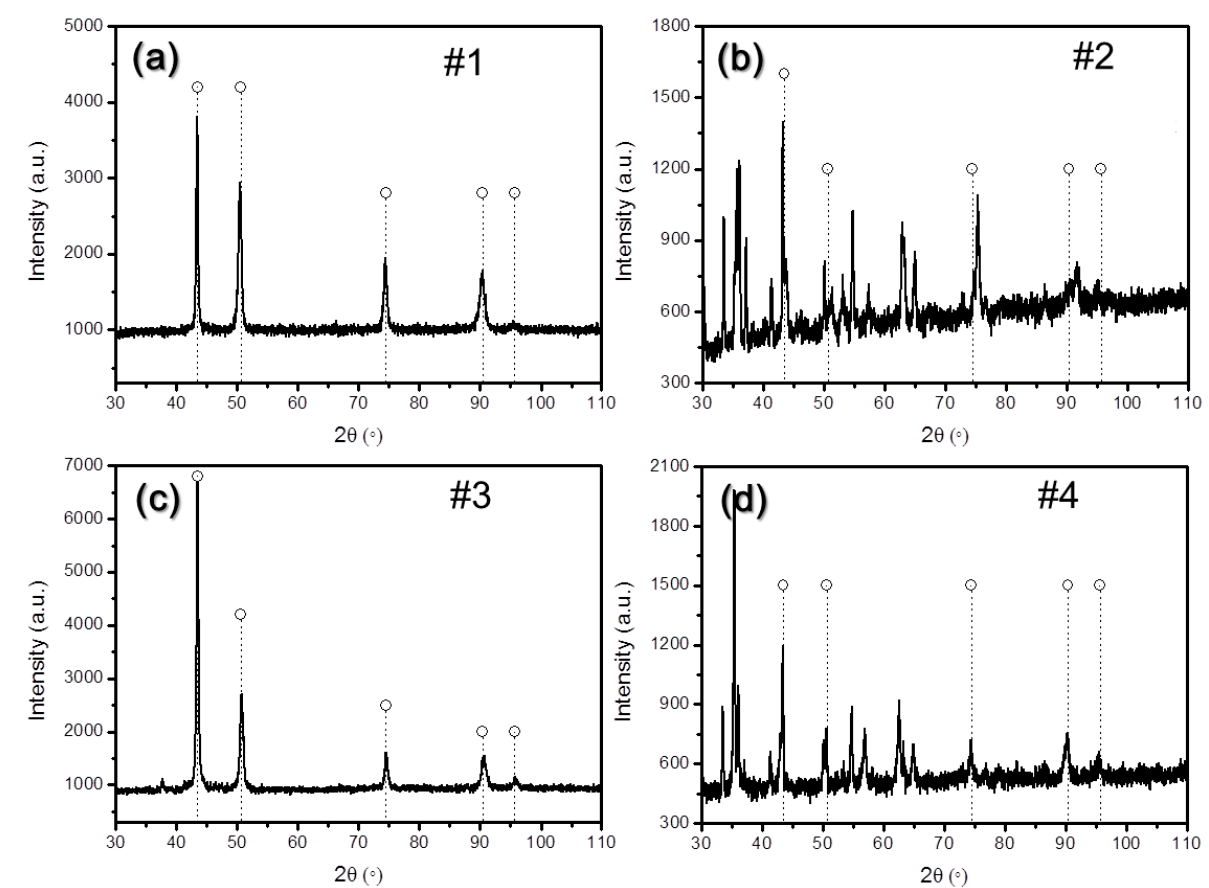
Figure 7. The surface XRD patterns of the Ni-based alloys before and after heat treatment: specimens ( a ) #1, ( b ) #2, ( c ) #3 and ( d ) #4.